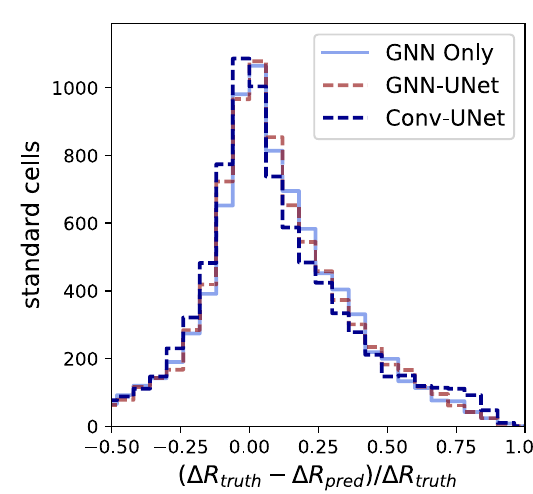
Fig. 8 (left) Schematic representation of three cells of the LG detector and the respective high-resolution super cells. The truth and predicted neutral energy component in the high resolution image are outlined in green and blue, respectively. The radial distance ( Δ R) between the